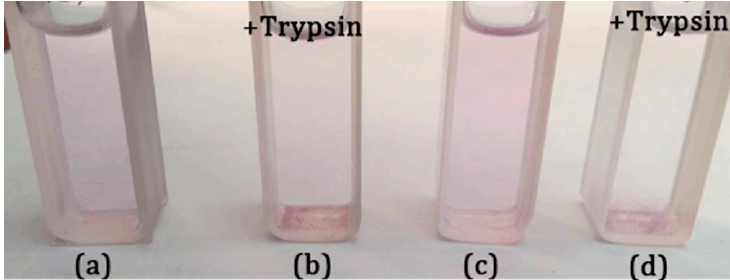
Figure 7. PNVP- b - dendr (Phe-Lys) 2 ( a , b ) and PNVP- b - dendr (Phe-Lys) 3 ( c , d ) loaded with Nile red and Figure 7. PNVP -b-dendr (Phe-Lys) 2 ( a , b ) and PNVP -b-dendr (Phe-Lys) 3 ( c , d ) loaded with Nile red and loaded with Nile red after the incubation 48 h with loaded with Nile red after the incubation 48 h with trypsin.